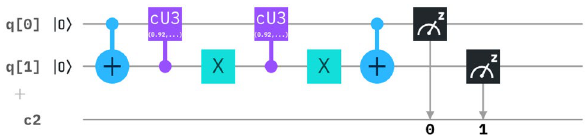
Figure 2. The derived circuit has a combination of a CNOT gate, control U3 gate, Anti-control U3 gate and a CNOT gate, where θ 1 = 2 B n ( r ) t , φ 1 = − π/ 2 and (cid:31) 1 = π/ 2 and θ 2 = 2 B n ( r ) t , φ 2 = π/ 2 and (cid:31) 2 = − π/ 2 .